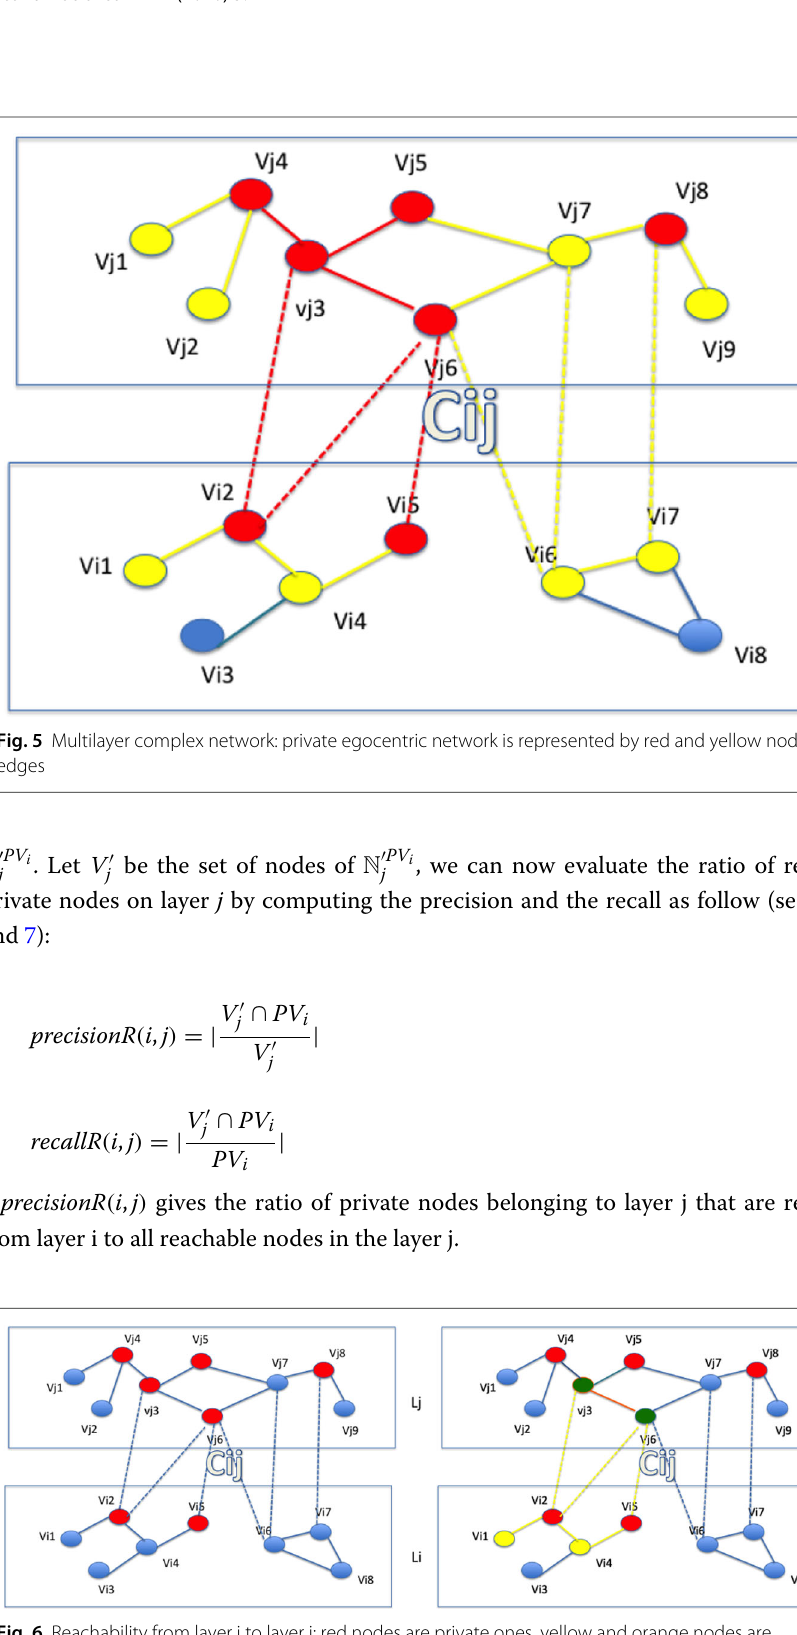
Fig. 6 Reachability from layer i to layer j: red nodes are private ones, yellow and orange nodes are egocentrics ones computed from layer i, green nodes are the egocentric ones that belong to the the private network of the layer j, precisionR(i,j)=1 and recallR(i,j)=0.4: this means that all reachable nodes from layer i are private ones but only 40% of private nodes of the layer j are reachable from layer